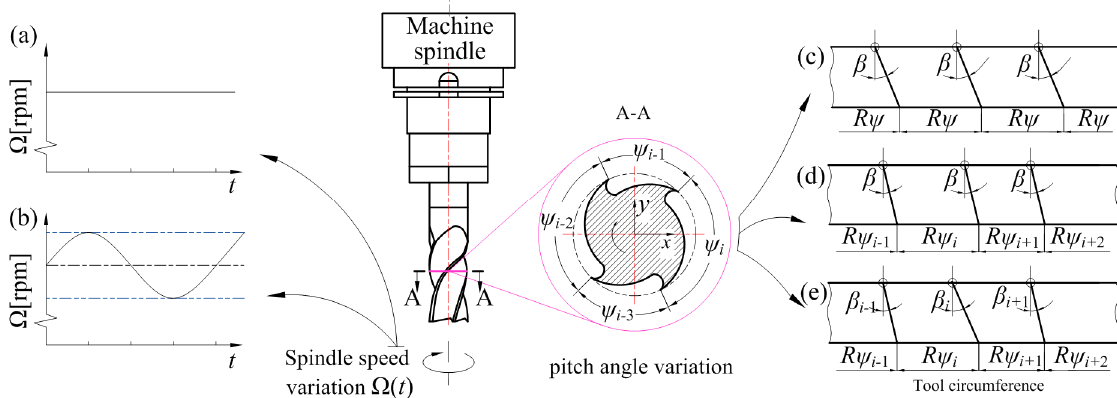
Figure 1. Schematic drawing of the process combinations associated with VSS and VPC/VHC. ( a ) constant speed; ( b ) VSS; ( c ) conventional cutter; ( d ) VPC; ( e ) VHC